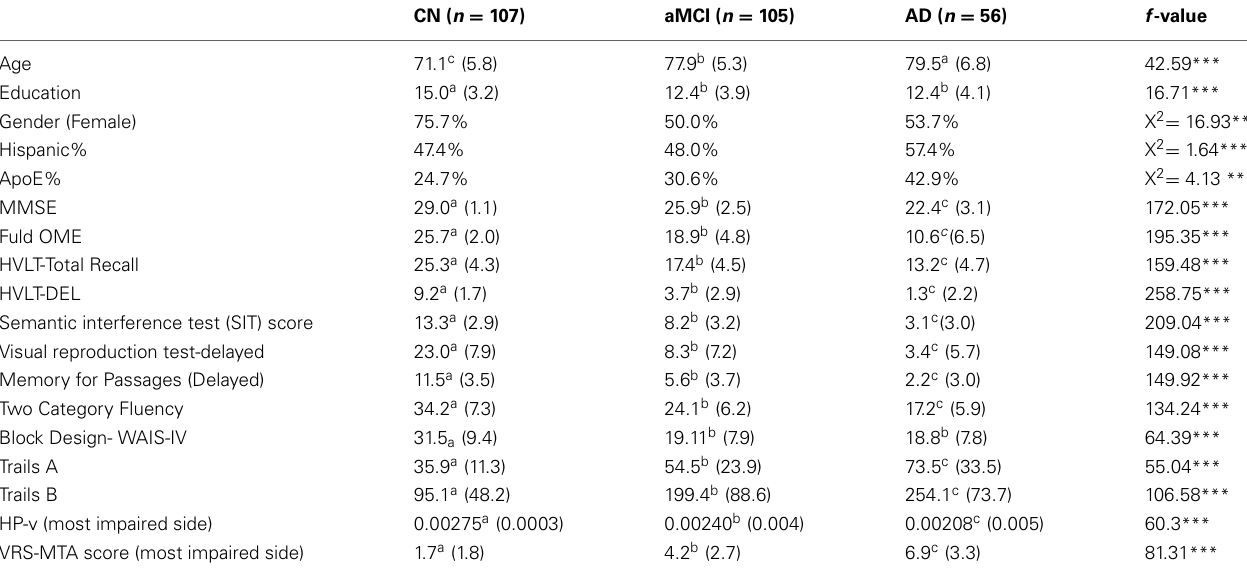
Table 1 | Demographics and MRI